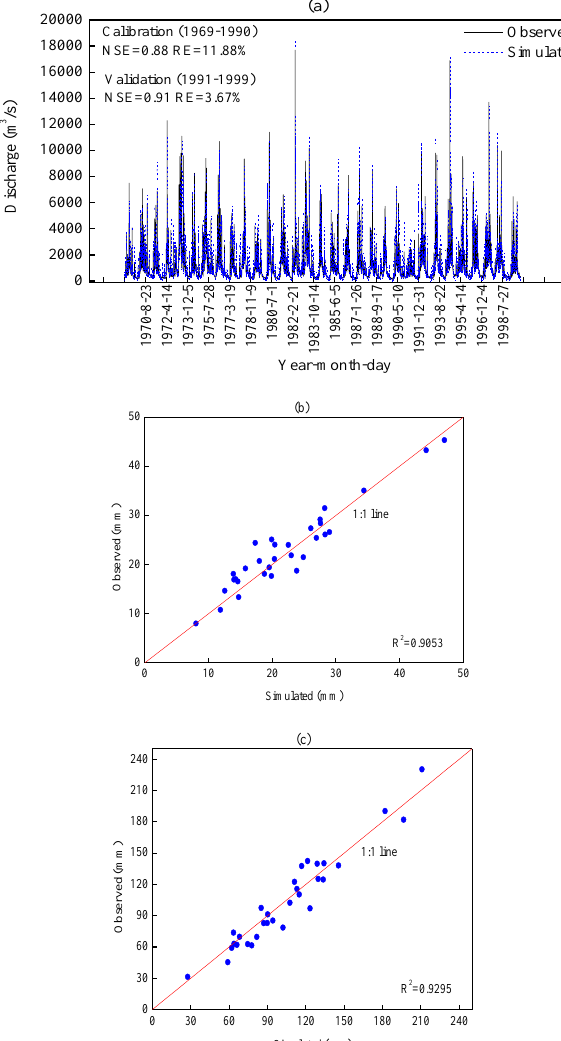
Figure 2. Comparison of the simulated and observed runoff at the Hengshi hydrologic station during the period 1969–1999. (a) A comparison of simulated and observed discharges, (b) a compari- son of simulated and observed maximum 1-day runoff depth, and (c) a comparison of simulated and observed maximum 7-day runoff